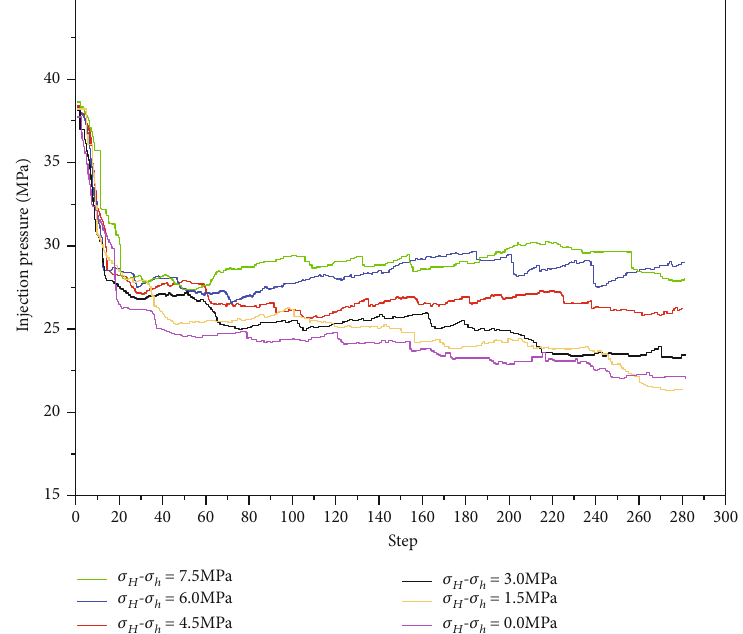
Figure 16: Injection pressure-step curves under di ff erent in-situ stress